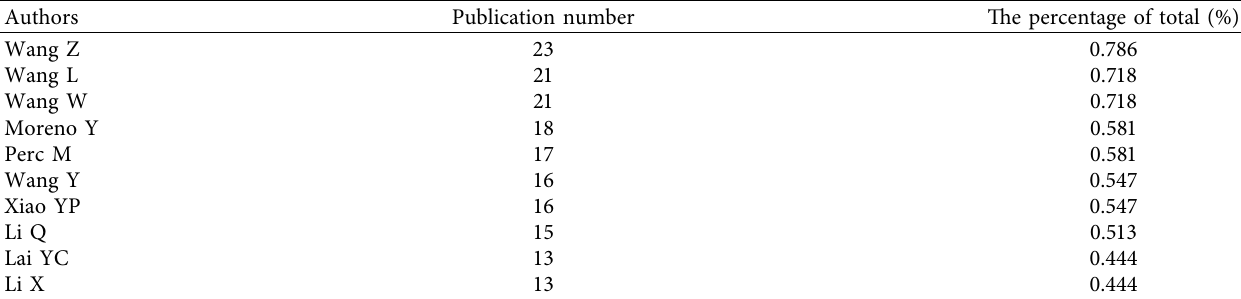
Table 3: Top 10 productive authors in the dynamic complex network